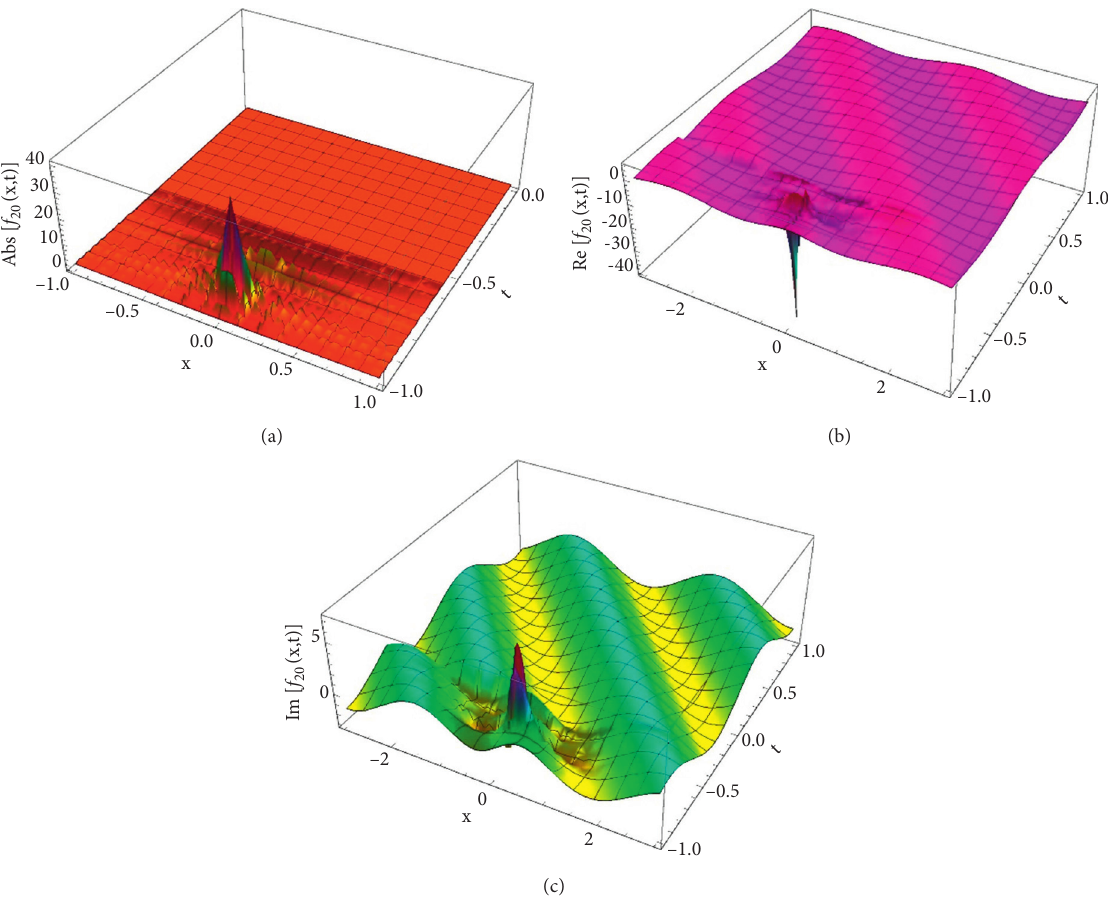
Figure 5: Optical soliton wave solutions of the absolute, real, and imaginary value of equation (26) in three-dimensional view ( c � − 1, c � − 4, and h � ϑ � 0 . 5, c 2 3